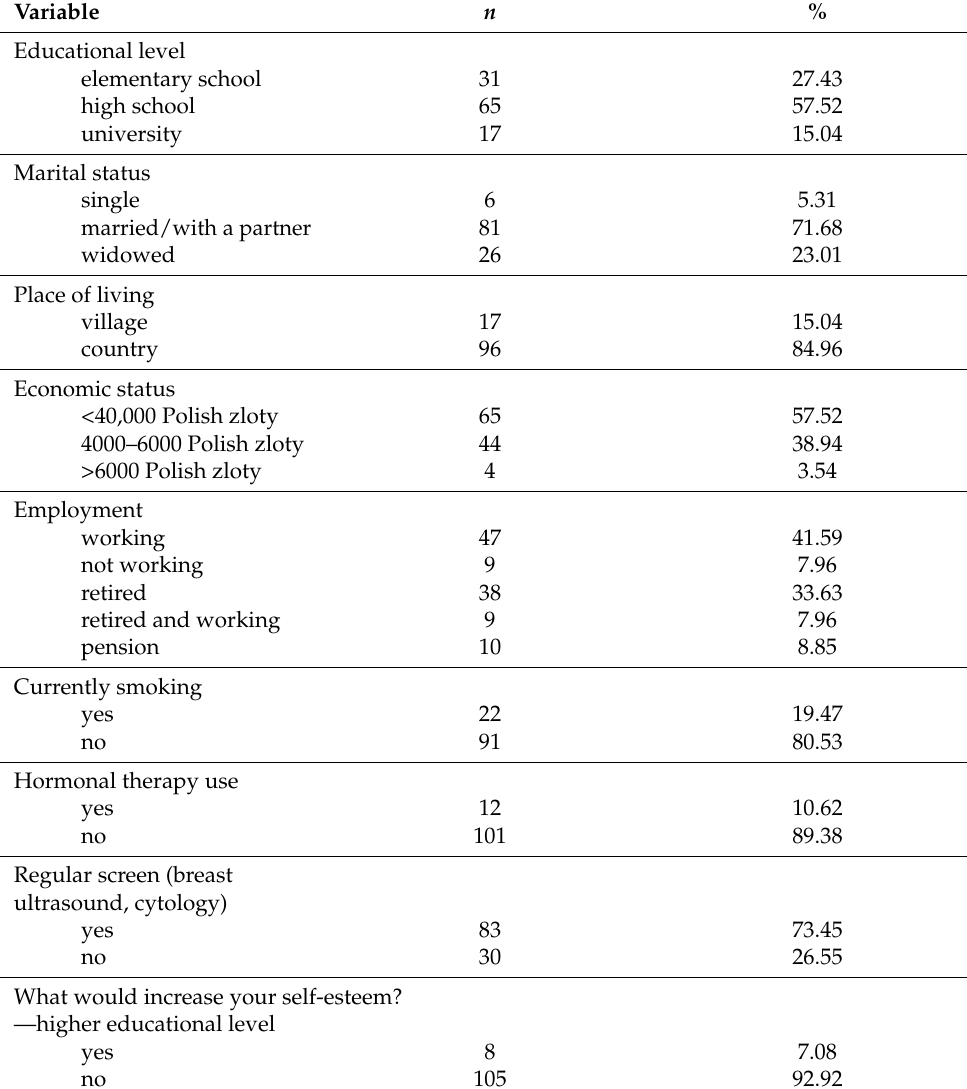
Table 1. Characteristics of the study group ( n